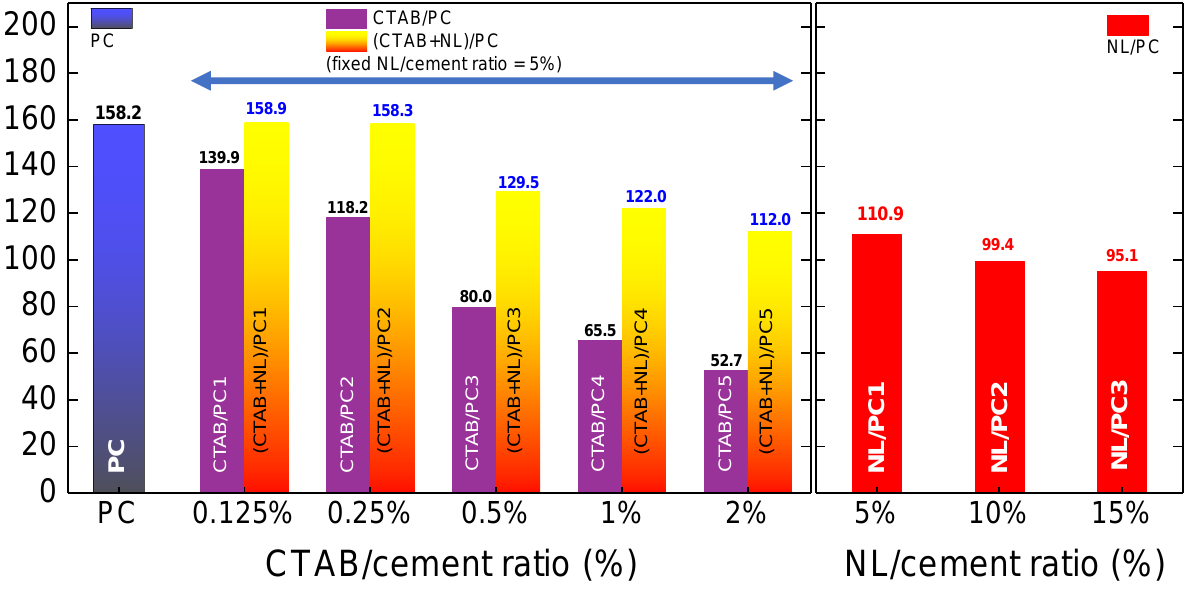
Figure 9. Optimized mechanical performance of the PC, CTAB/PC, NL/PC, and (CTAB + NL)/PC composites.